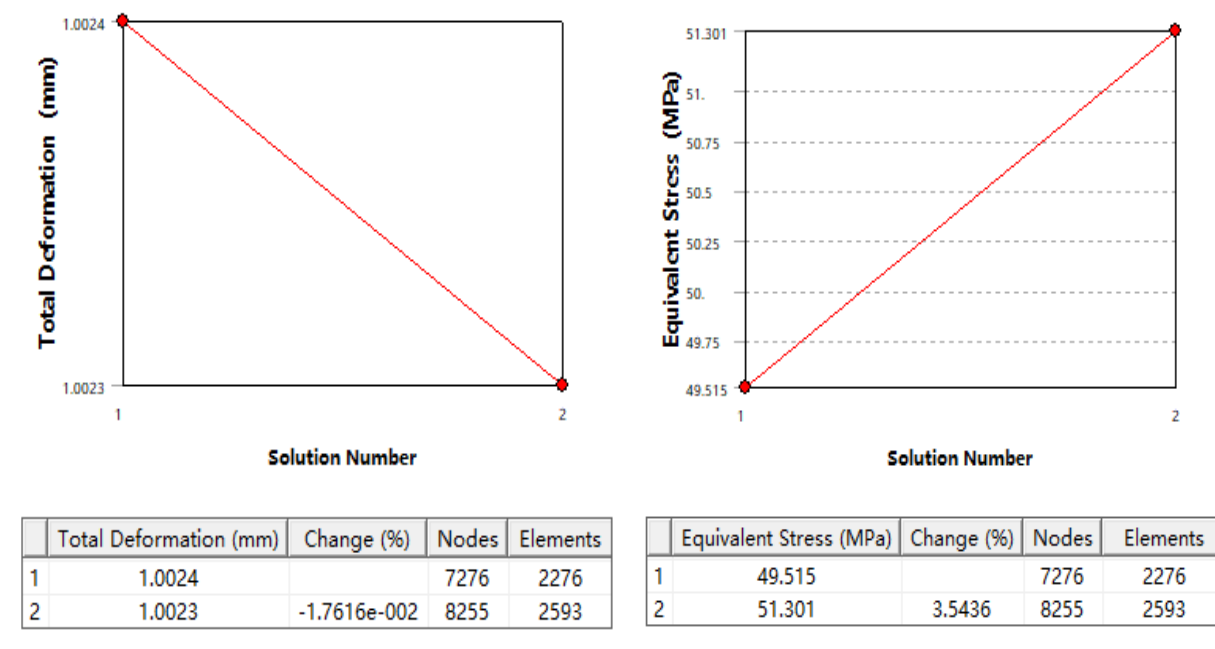
Figure 4. Combination seal ring convergence analysis.